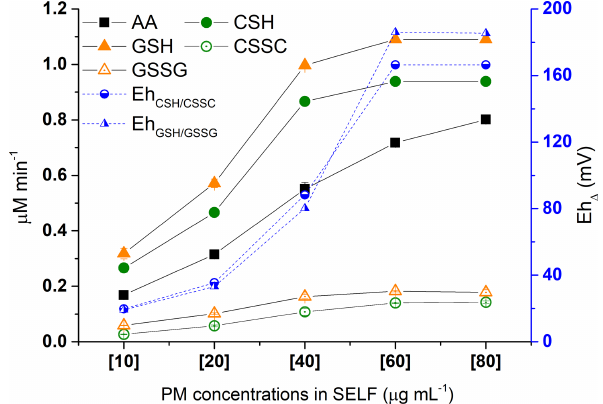
Figure 5. Application of the antioxidant assay to PM 2 . 5 samples (A–C) from the NAPS station in Hamilton. Samples were incubated in SELF-a for 180min. The lines connecting the markers are used to indicate the trends among the